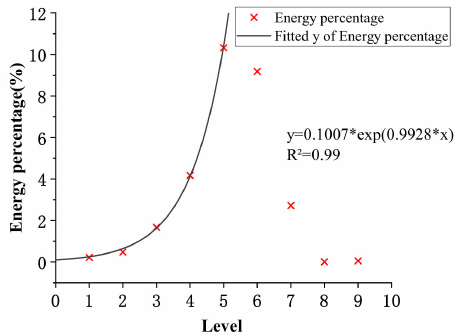
Figure 6. Relation between the number of wavelet decompositions and the proportion of